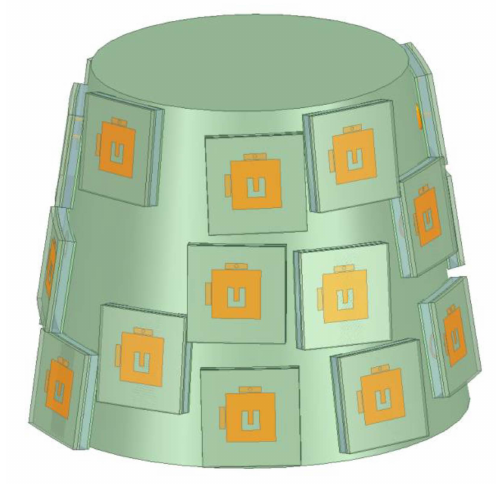
Figure 5. An example of implemented antenna